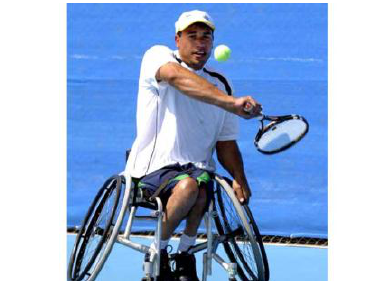
Figura 2. http://pan2007.globo.com/ESP/Home/foto/0,,11284717- EX,00.jpg